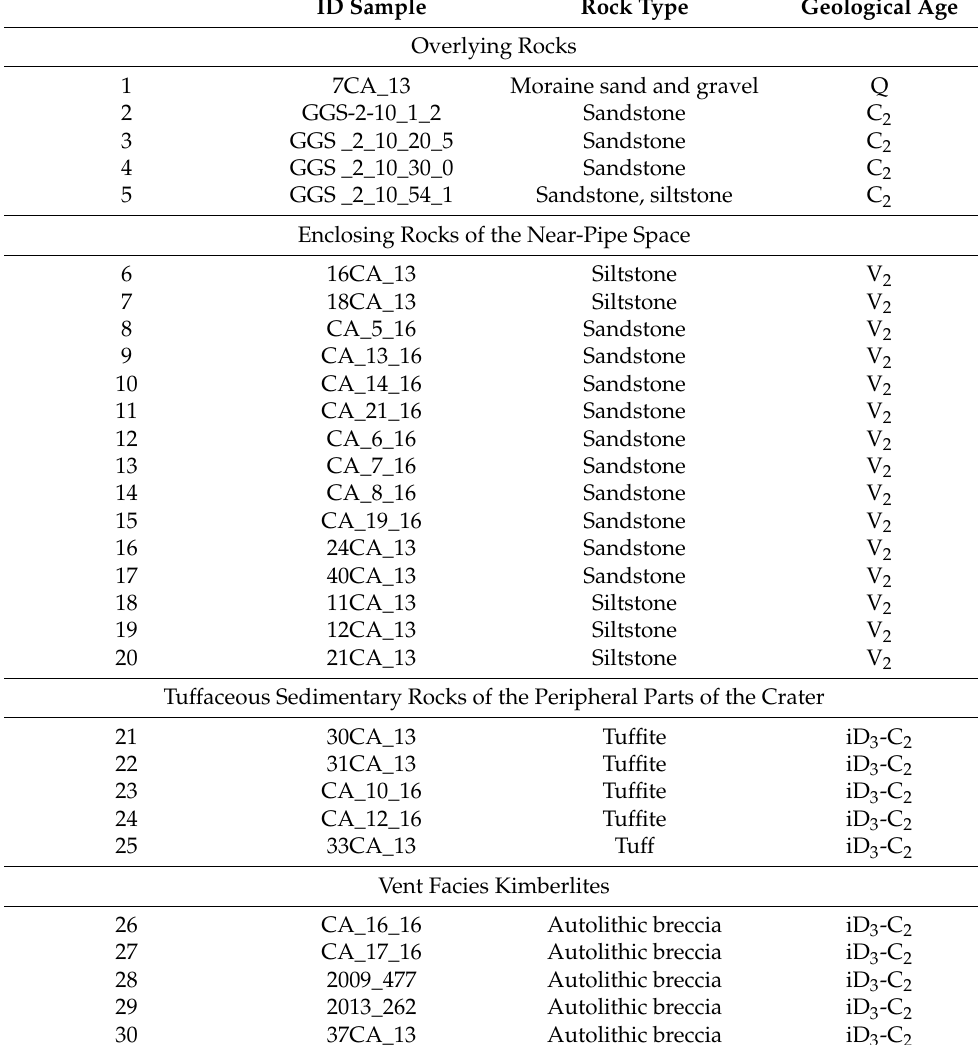
Table 1. General characteristics of the investigated samples. ID